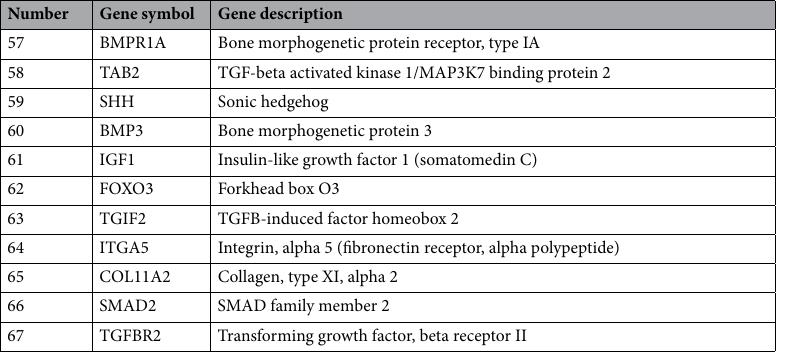
Table 3. The genes involved in EMT/fibrosis pathway, which were predicted to be targeted and regulated by miR-27a. The genes are sorted based on their targeting score.